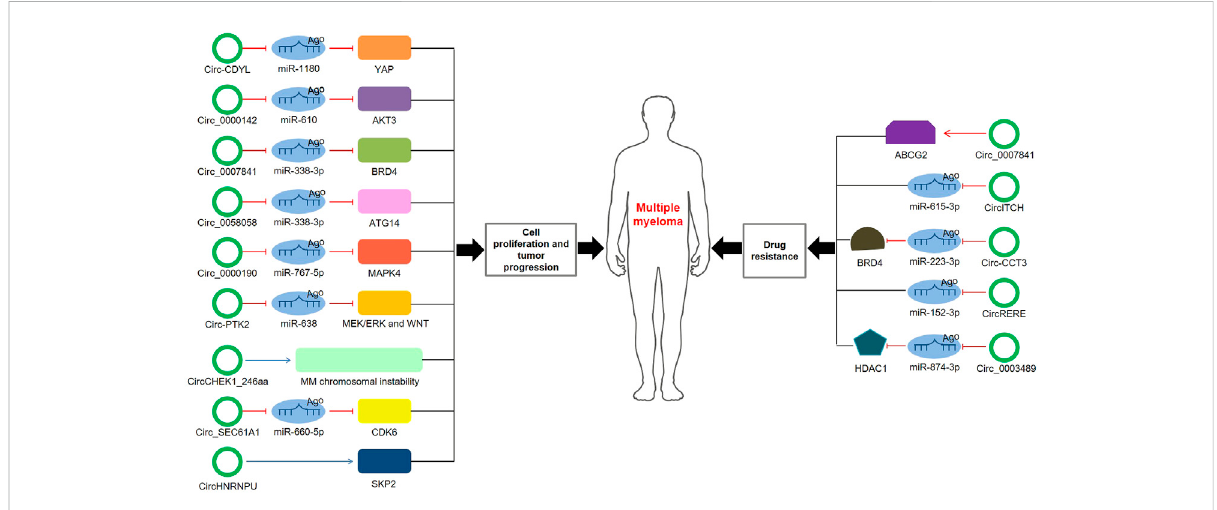
FIGURE 3 TheroleandregulatorymechanismsofcircRNAsinMM.TheschematicdiagramdepictstheknownrolesofcircRNAsinMMprogressionandthe ways that circRNAs are involved in miRNA-associated gene or gene regulatory